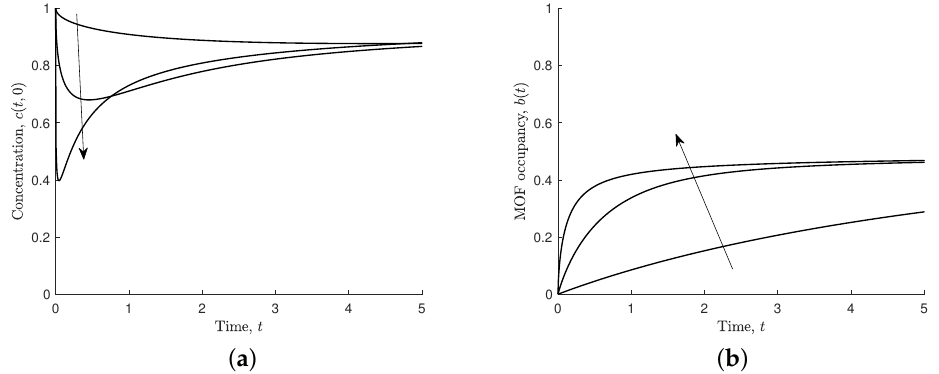
Figure 6. Results for different values of effective association, s 2 = 0.1,1,10, and s 1 = s 3 = s 4 = 1. Arrows indicate the direction of increasing s 2 . ( a ) Non-dimensional concentration of ferric ions at MOF–polymer boundary, c ( t ,0 ) . ( b ) Non-dimensional MOF occupancy, b ( t ) .